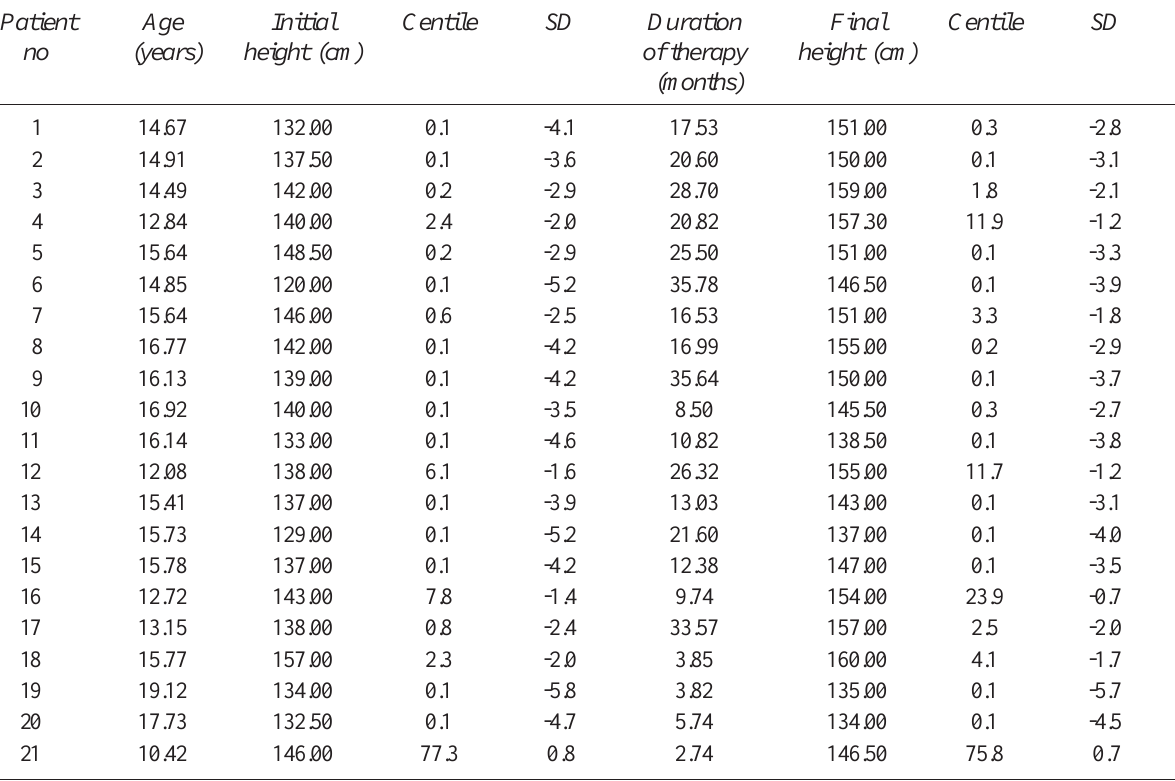
Table 3. Percentile and standard deviation of patients’ initial and final